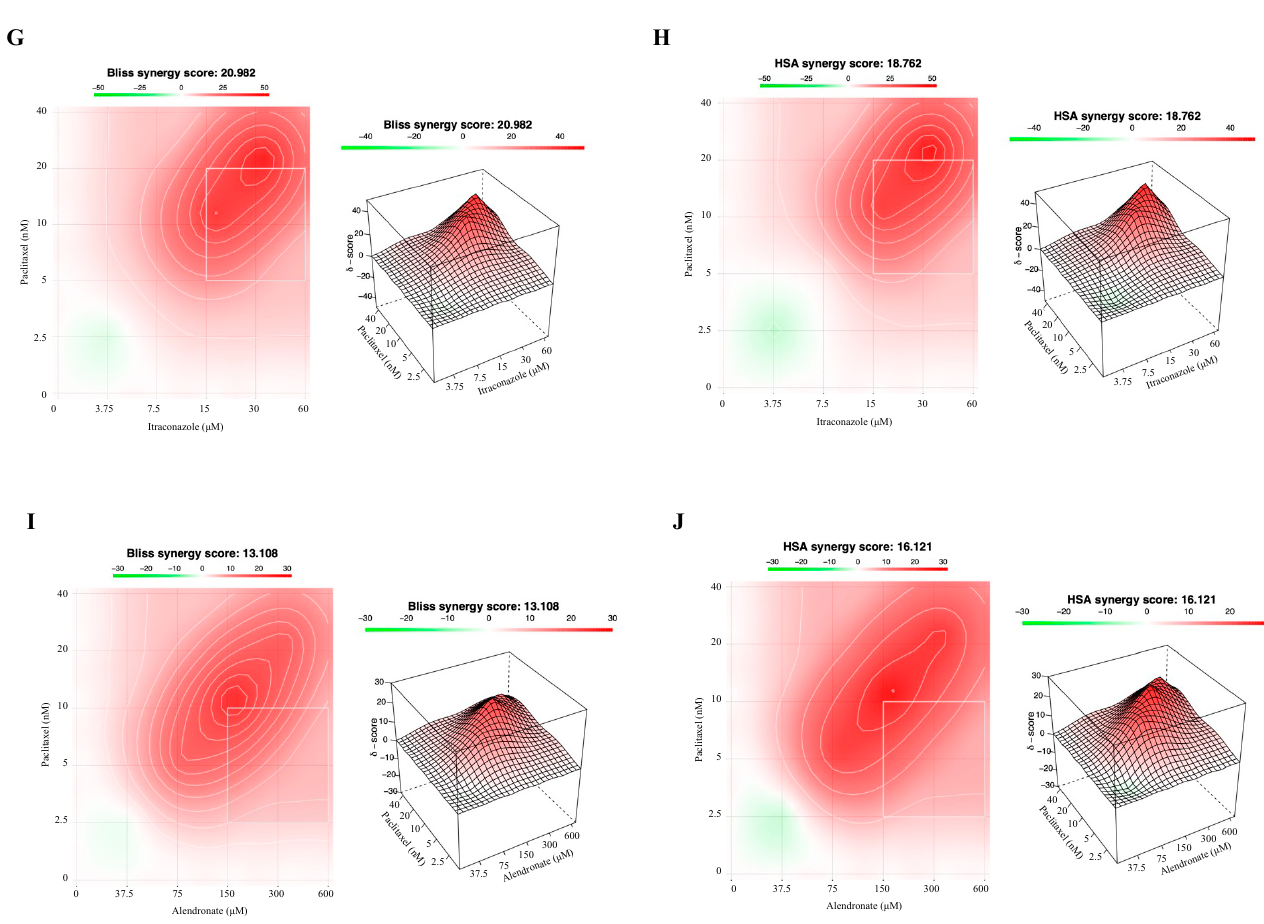
Figure 6. Combining Paclitaxel with repurposed drugs has a synergistic effect on OVCAR8 PTX R P. ( A – J ) Bliss Independence and High Single Agent synergy 2D and 3D plots showing drug synergism of OVCAR8 PTX R P cells, after exposure to a fixed-dose ratio that corresponds to 0.25, 0.5, 1, 2 and 4 times the individual IC 50 values for each drug, e.g., Paclitaxel combined with ( A , B ) Pitavastatin, ( C , D ) Metformin, ( E , F ) Ivermectin, ( G , H ) Itraconazole and ( I , J ) Alendronate for 48 h. The combined treatment was co-administered at the same time. All assays were performed in triplicate in at least three independent experiments. Synergy score: <10 (antagonism, green), =1 (additivity, white) and >10 (synergism, red).